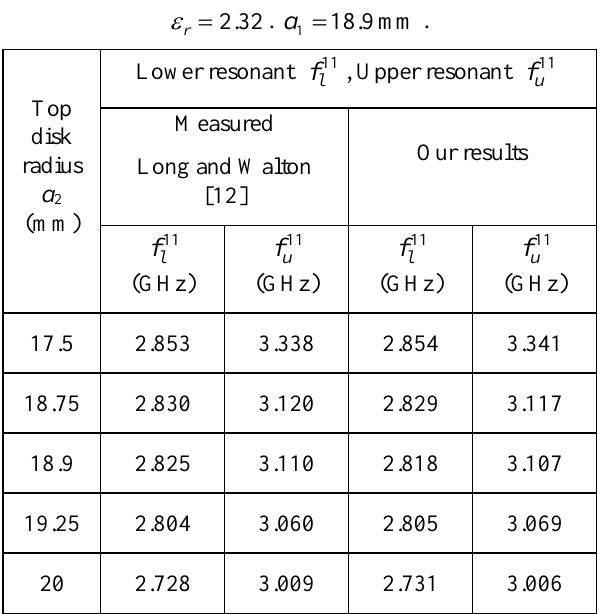
Table 2: Comparison of calculated lower and upper resonant frequencies with experimental data, for two stacked circular disks fabricated on a two-layered